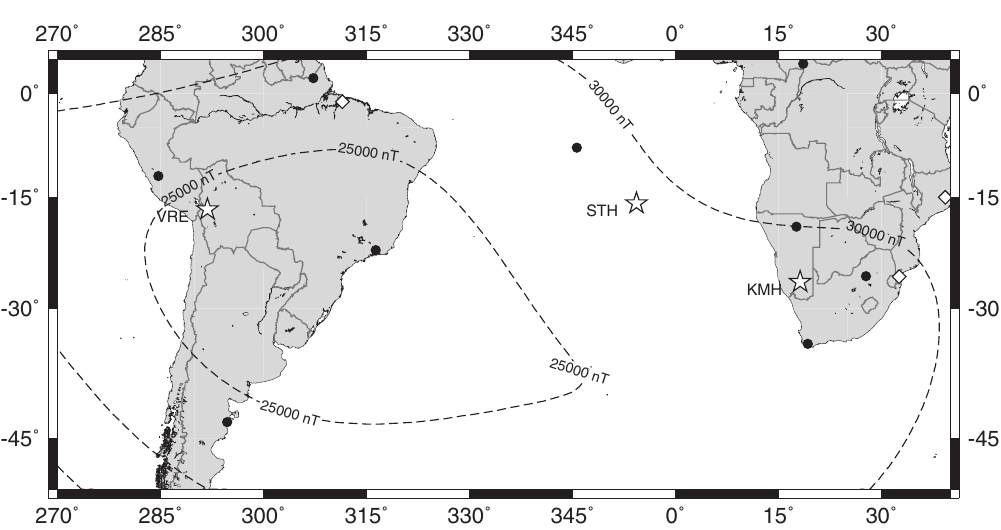
Fig. 2. Location of new observatories in the SAA region (stars): Villa Remedios (VRE), Keetmanshoop (KMH) and St. Helena (STH). Existing observatories that participate in the INTERMAGNET programme (black dots) or not (diamonds) are also